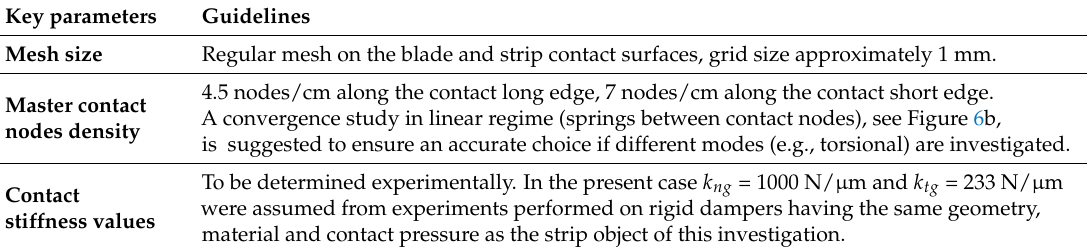
Table 3. Guidelines in a